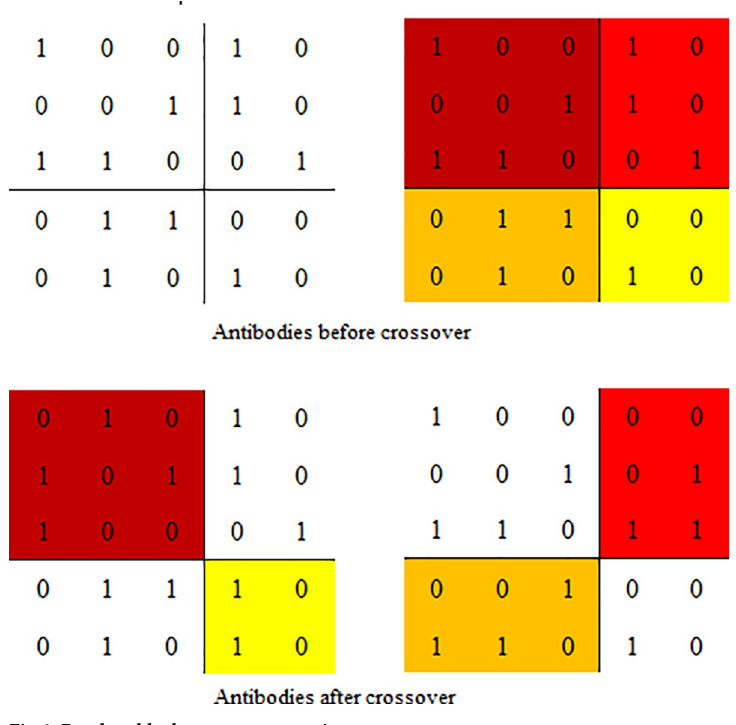
Fig 6. Random block crossover